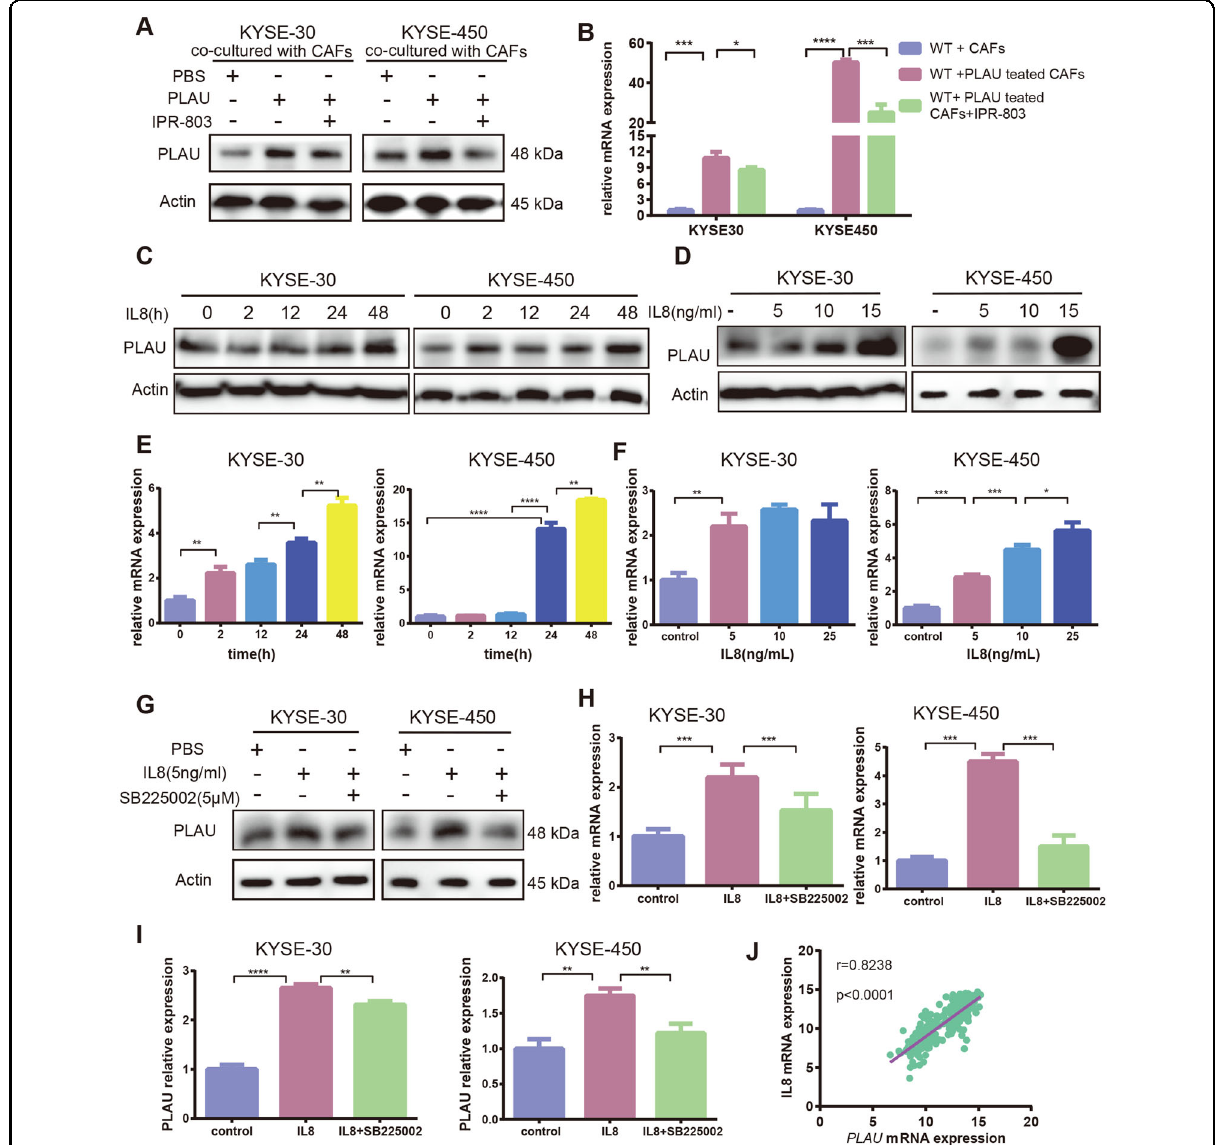
Fig. 7 IL8 secreted by CAFs upregulated PLAU expression in tumor cells. A , B Detection of PLAU expression of WT KYSE-30 and KYSE-450 cells cocultured with CAFs treated with recombinant uPA in the presence or absence of IPR-803, a uPA-uPAR inhibitor, as assessed by western blot ( A ) and RT-qPCR ( B ). C – F Western blot and RT-qPCR were performed to detect PLAU expression of WT KYSE-30 and KYSE-450 cells exposed to recombinant IL8 treatments at different times ( C , E ) and concentrations ( D , F ). G – I Detection of PLAU expression in WT KYSE-30 and KYSE-450 cells with recombinant IL8 treatment in presence or absence of SB225005, a CXCR2 inhibitor, by western blot ( G ), RT-qPCR ( H ), and ELISA ( I ). J